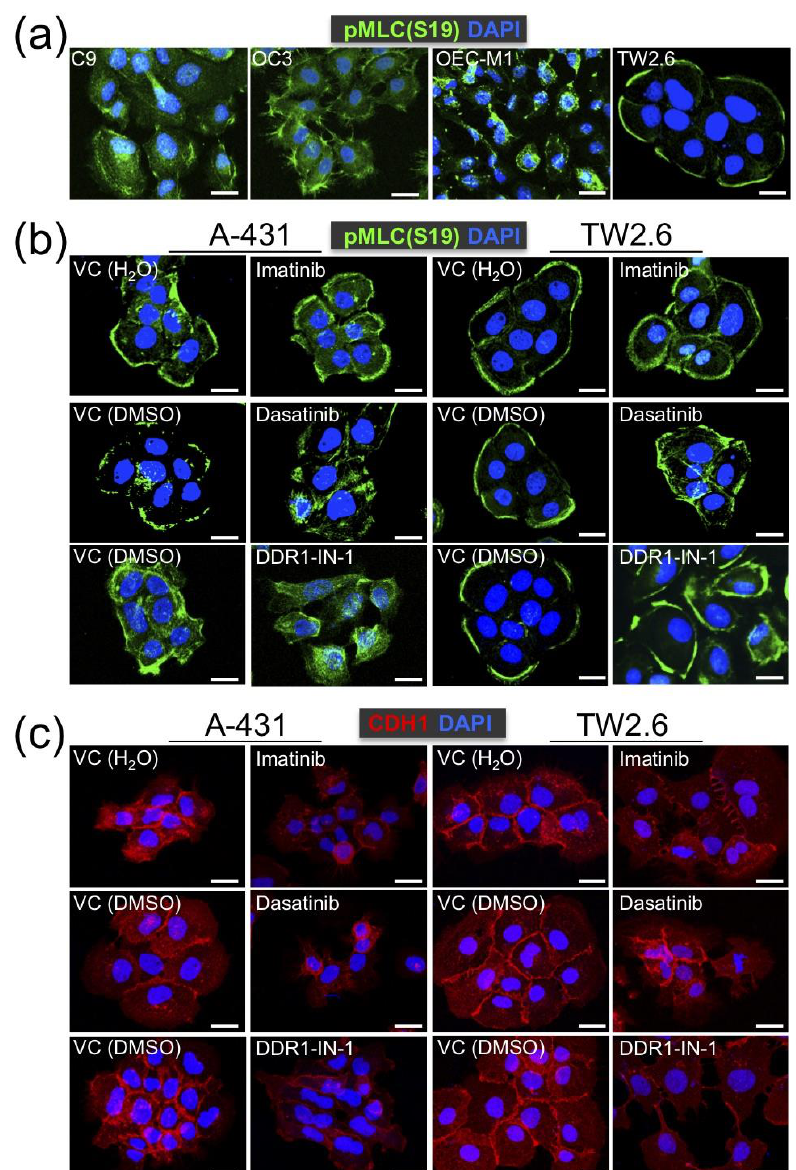
Figure 5. Kinase activity of DDR1 is involved in cohesive cell cluster formation. ( a ) Confocal-microscopic cell images of Ser19-phosphorylated myosin light chain (pMLC (S19)) staining (green) in the indicated OSCC cell lines. Nuclei were counterstained with DAPI (blue). Multi-cell cohesiveness, as evident by decreased pMLC (S19) staining at cell–cell contacts, was only observed in TW2.6 cells. ( b ) Confocal images of pMLC (S19) staining in A-431 (left) and TW2.6 (right) cells treated with vehicle control (VC) or DDR1 inhibitors (10 μM imatinib, 0.1 μM dasatinib, or 10 μM DDR1-IN-1). ( c ) Confocal images of CDH1 staining (red) in A-431 and TW2.6 treated with VC or DDR1 inhibitors. Scale bars, 20 μm.